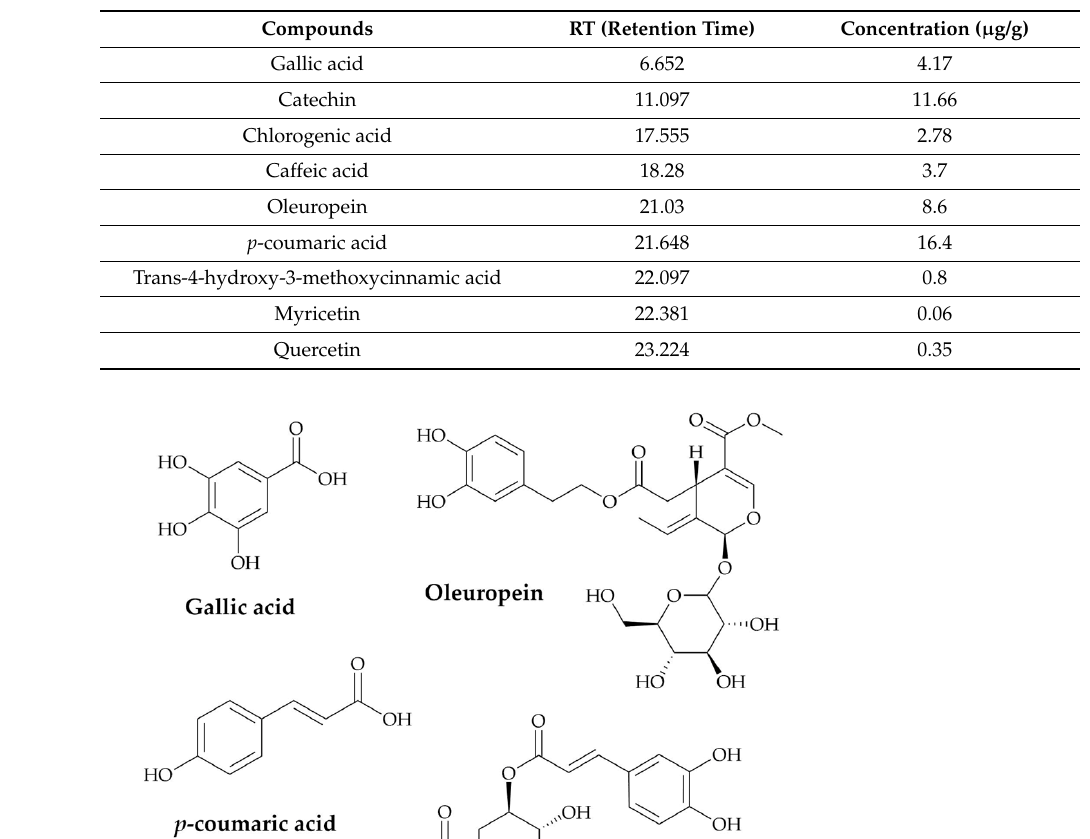
Table 1. Chemical composition of the PATE.